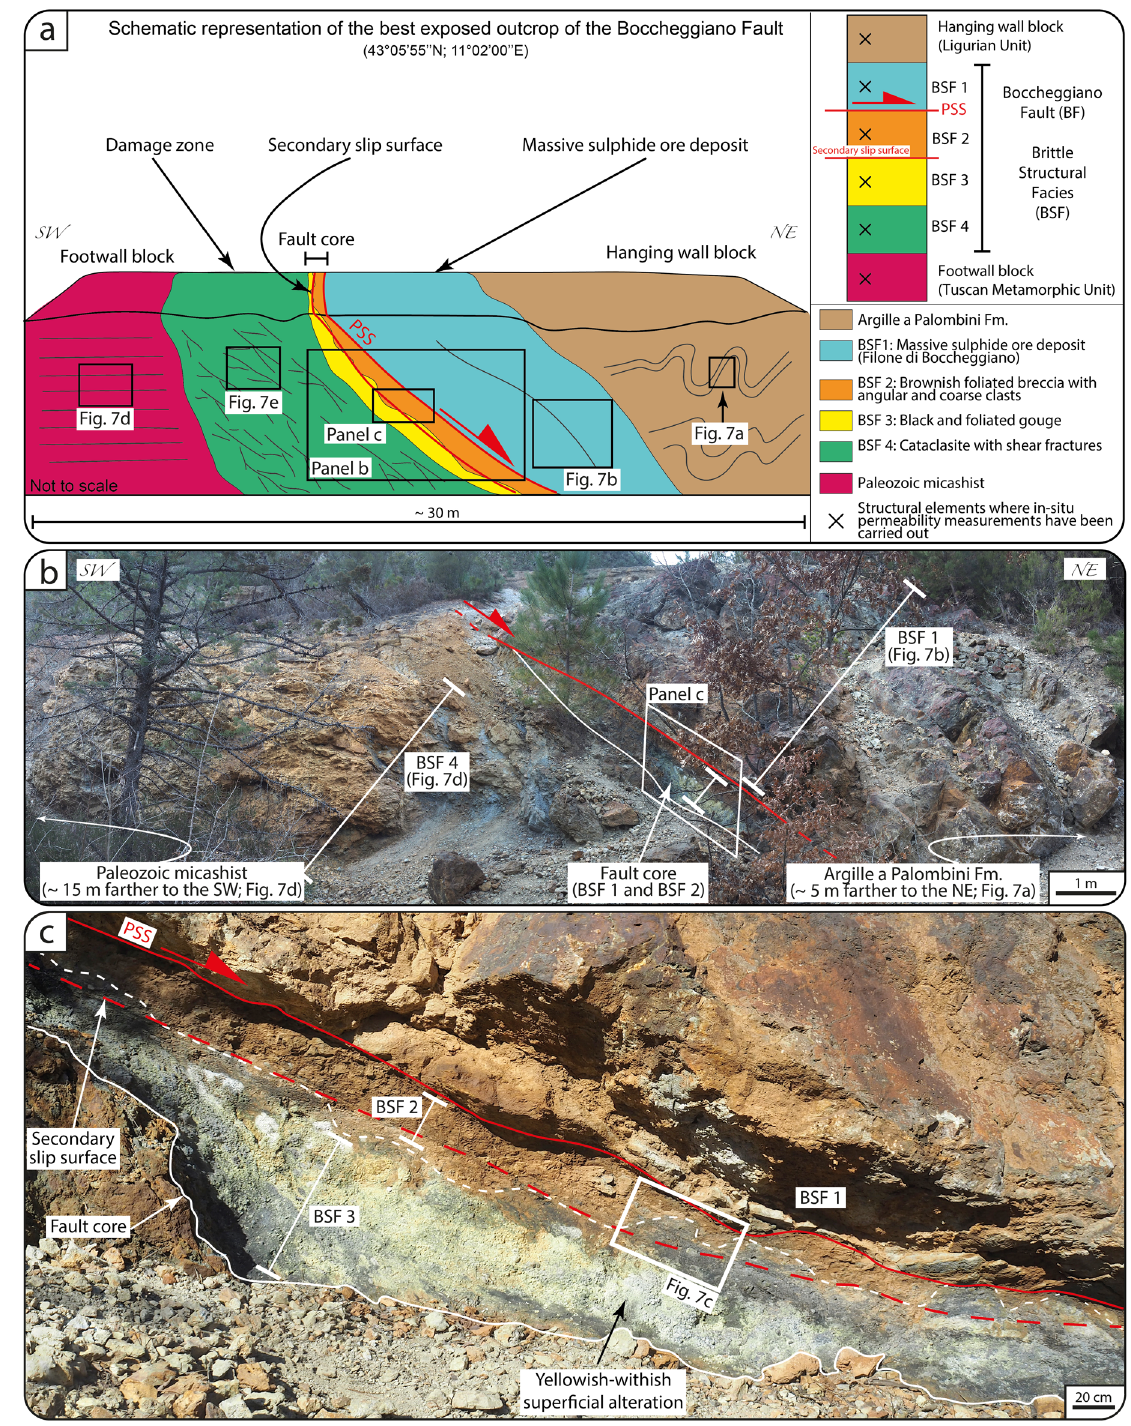
Figure 6. ( a ) Schematic representation of the best exposed outcrop of the Boccheggiano Fault where we carried out in-situ outcrop permeability measurements. The distribution of BSFs along the Boccheggiano fault is shown. ( b ) Outcrop of the Boccheggiano Fault showing the BSFs forming the complex architecture of the Boccheggiano Fault. ( c ) Detail of the BSF2 and BSF3 forming the fault core of the Boccheggiano